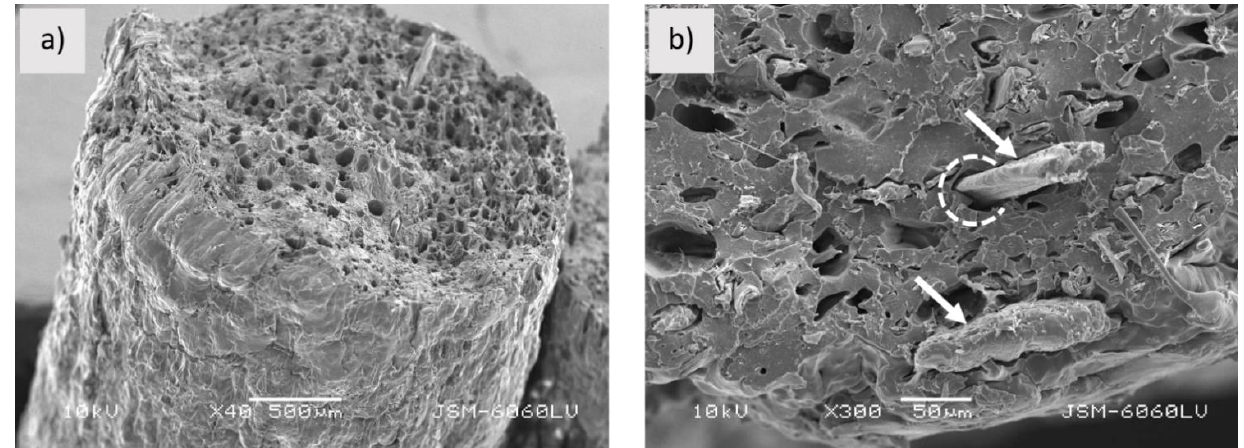
Figure 2. Sample PLA-Woodfill_f; ( a ) fractured surface (mag. 40×), ( b ) pulled out fibres (pointed by arrows) and gaps between PLA matrix and wood fibres (indicated by dotted circle) (mag. 300×).